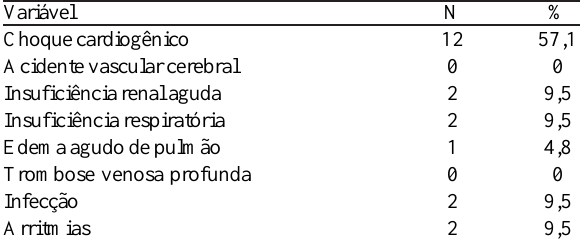
Tabela 4. Avaliação das complicações